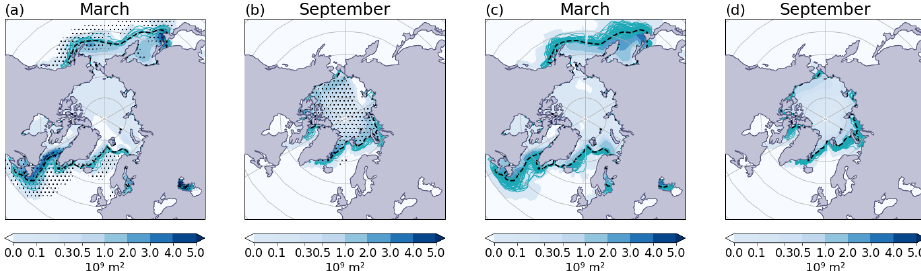
Figure 4. The March and September mean sea-ice area anomaly in contours and the sea-ice extent represented by the teal lines for 2 years after the eruptions (a–b) and 20 years after the eruptions (c–d) . All variables are given as anomalies with respect to 1–1850CE. The black hashed line is the mean sea-ice extent in the control run, and the 2 σ significant sea-ice area anomalies are stippled.